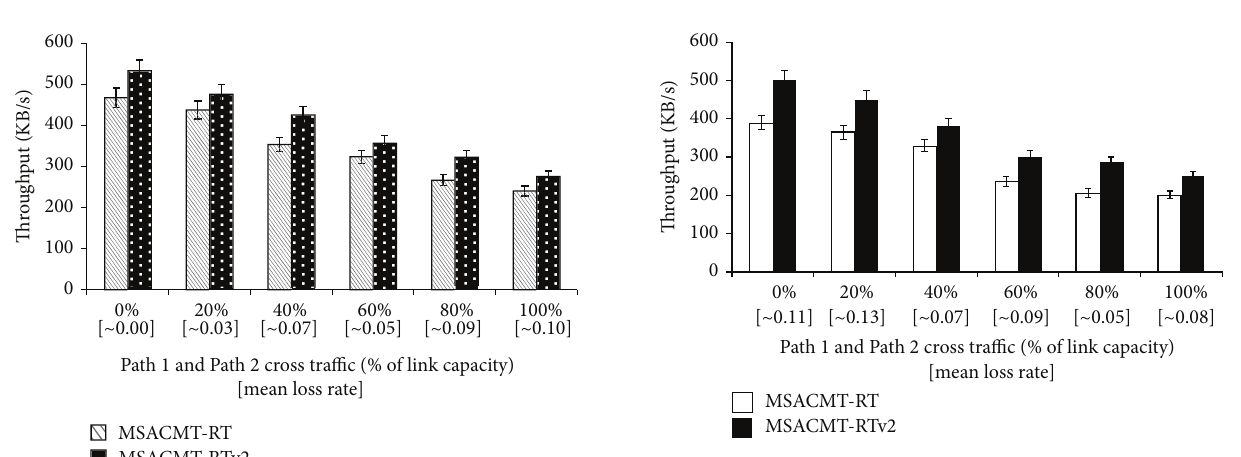
Figure 10: MSACMT-RT versus MSACMT-RTv2 during asymmet- ric loss conditions, when Path 3 = 50% cross